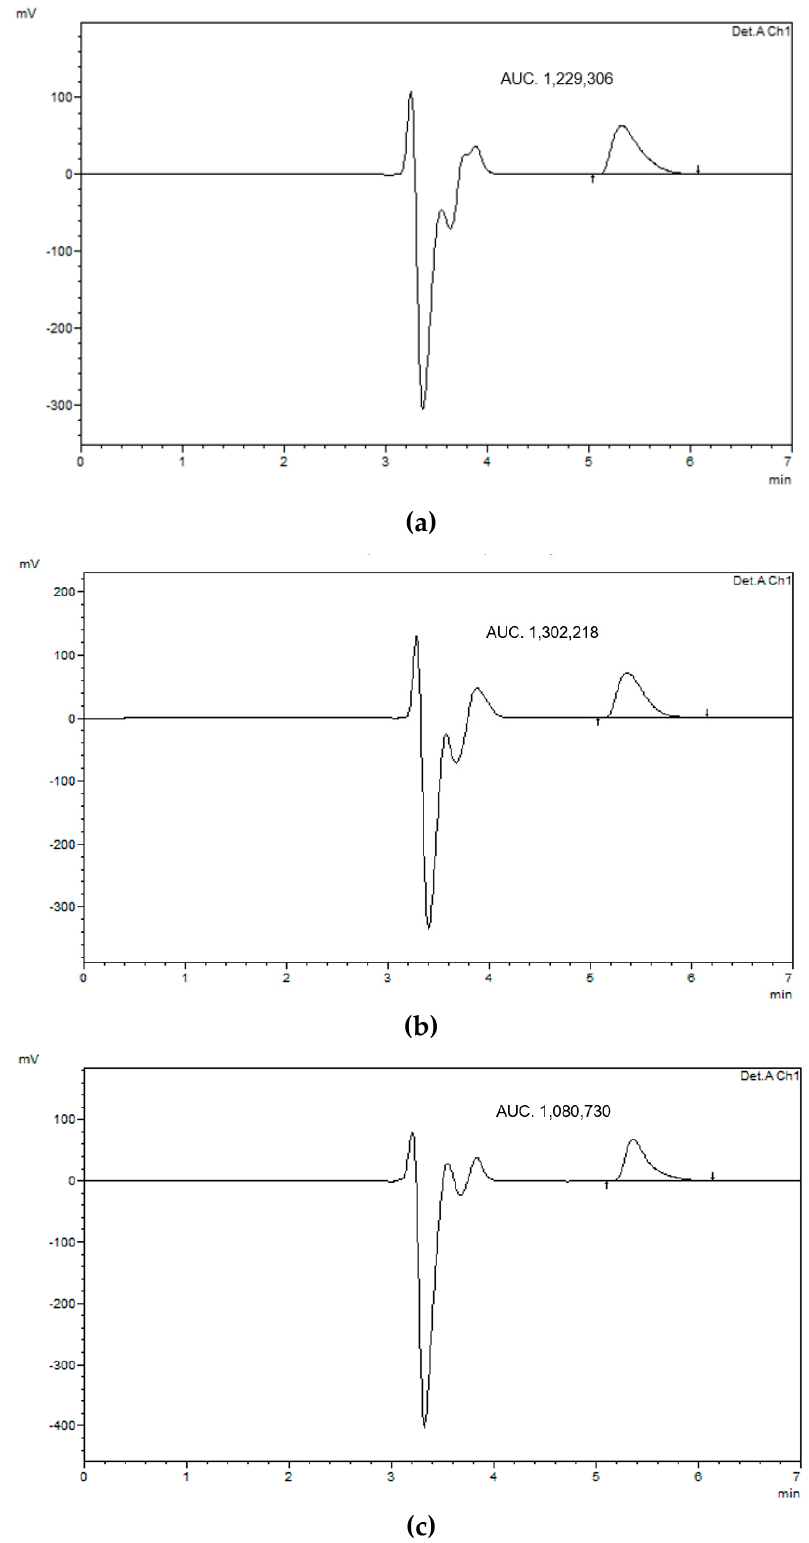
Figure 3. HPLC chromatogram of entrapment study after 24 h of lidocaine-loaded nanoemulsion using ( a ) beeswax, ( b ) coconut oil, and ( c ) oleic acid.